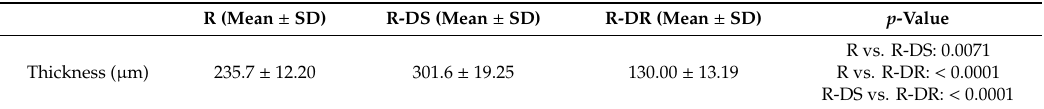
Table 2. THICKNESS—Articular